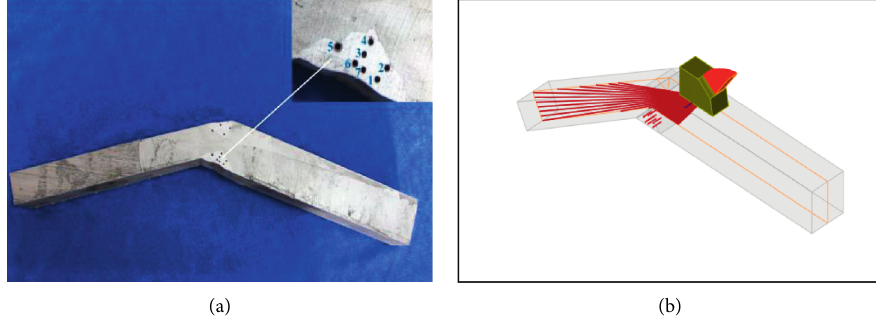
Figure 1: Irregular structure weld test block:(a) physical drawing; (b) 3D